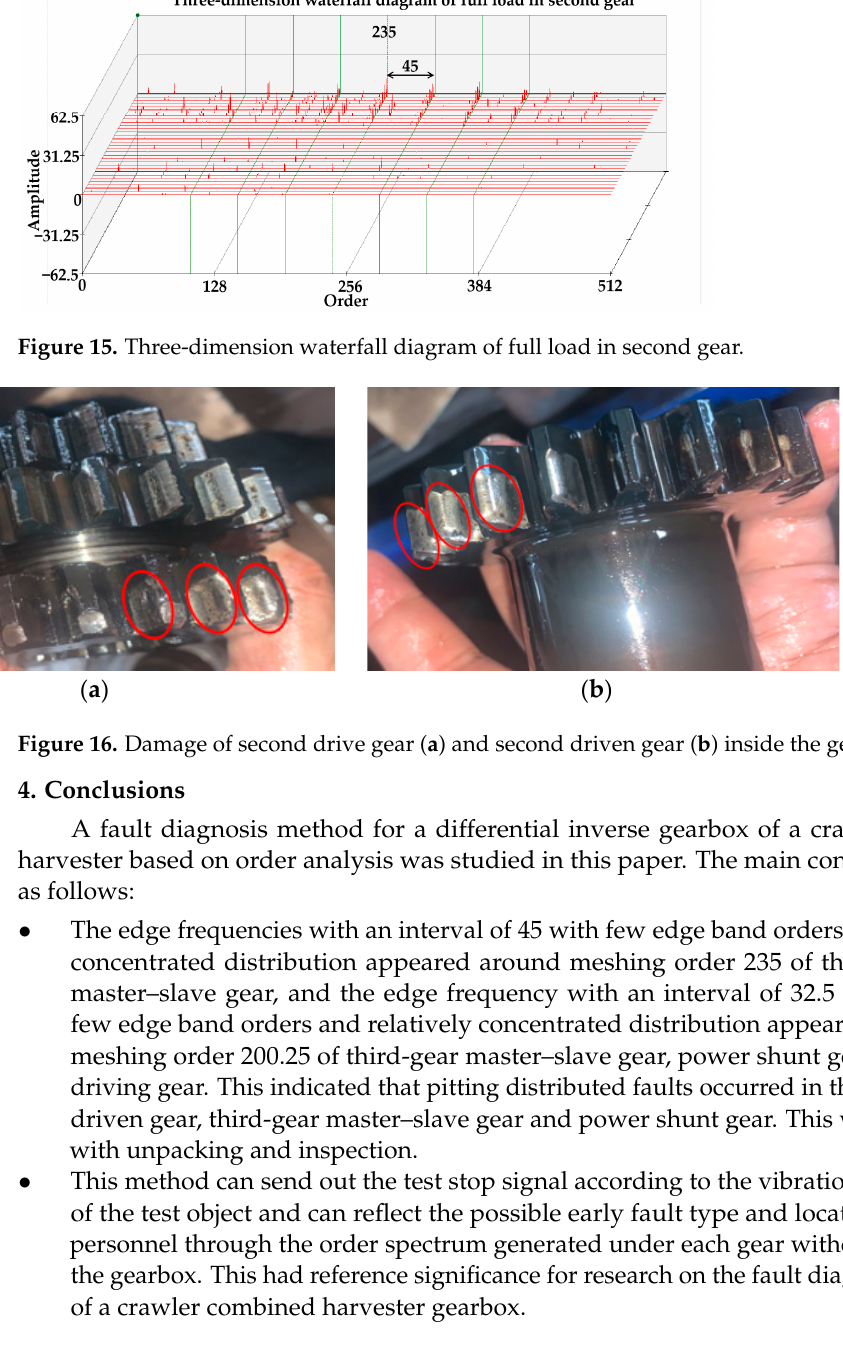
Figure 14. Three-dimension waterfall diagram ( a ) and drawing of partial enlargement ( b ) of differ- ence spectrum of small load in second gear.